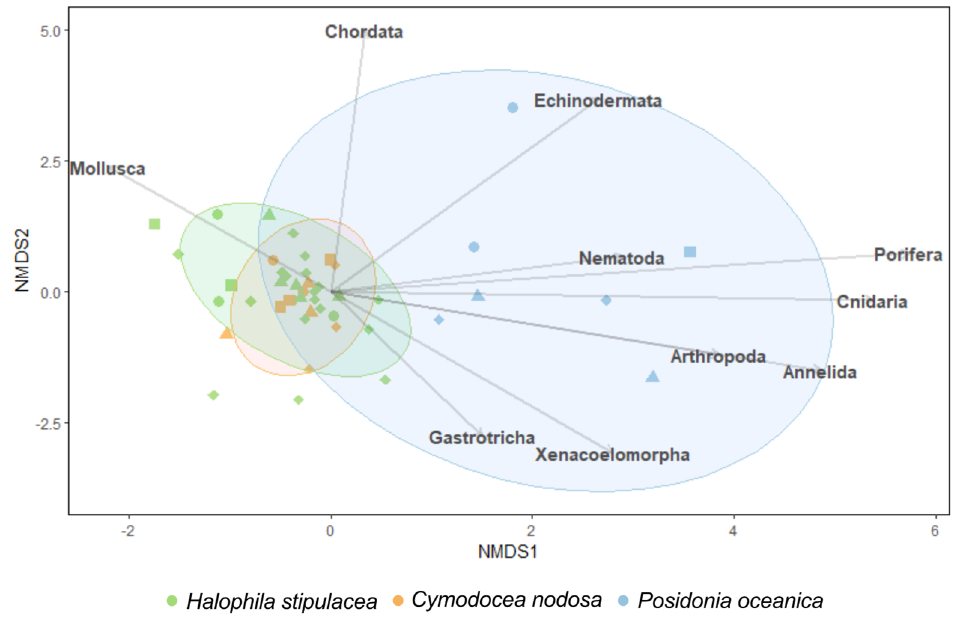
Figure 5. Nonmetric multidimensional scaling plot of temporal changes in metazoan communities within seagrass meadows ( H. stipulacea in green; C. nodosa in orange; and P. oceanica in blue). Ellipses show 95% standard error around the mean the three seagrasses and dark grey arrows indicate significant relationship ( p < 0.05) between the NMDS axes and different metazoan phyla. Greater length of arrows indicates greater r 2 value and is relative to the importance of the explanatory variable in the ordination, and the arrow direction indicates positive or negative correlations. Kruskal stress = 0.16.